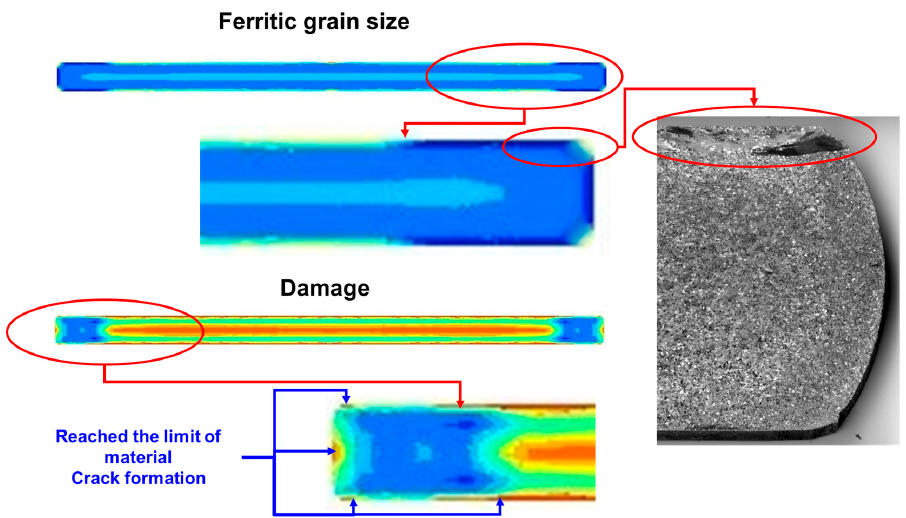
Figure 15. Comparison between macrography of the bar and the grain growth resulting from the maps of ferrite grain size and damage.